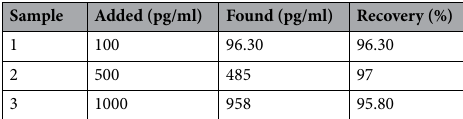
Table 1. Recoveries of BPA in the urine samples (n =